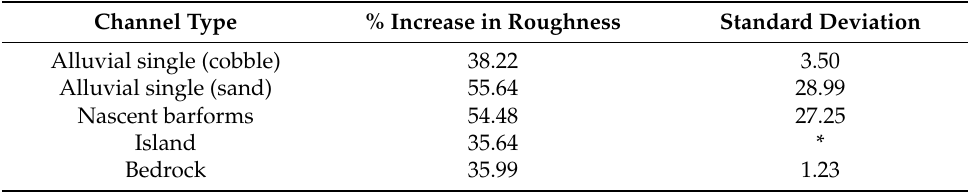
Table 8. Channel type and contribution of vegetation to channel roughness